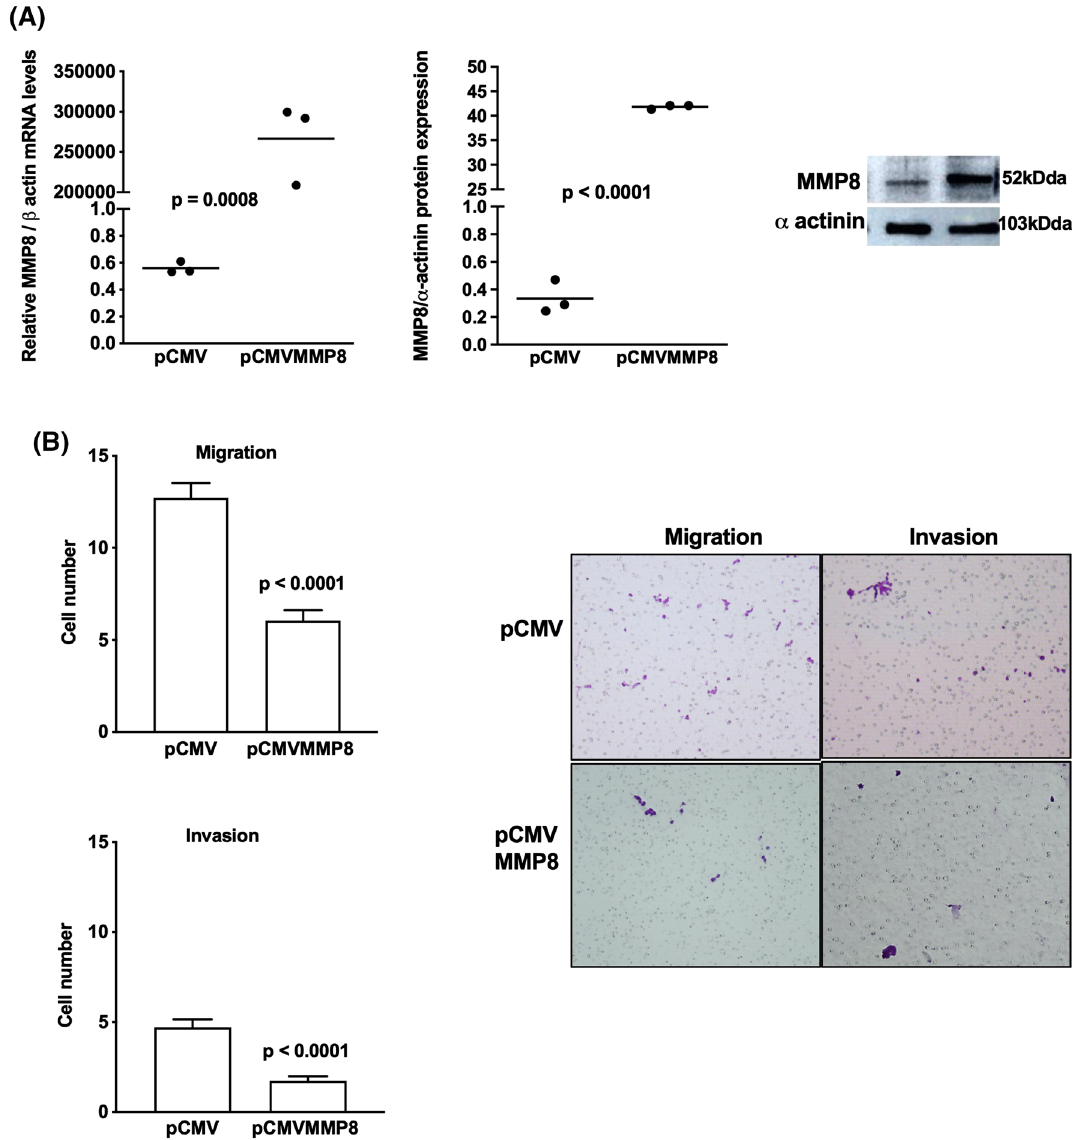
Fig. 8 Overexpression of metalloproteinase MMP-8 in adrenocortical carcinoma cells. A MMP-8 expression in H295R cells transfected with pCMVMMP-8 and empty vector; representative immunoblot of MMP-8 expression; B migration and invasion assays in H295R transfected with pCMVMMP-8 and representative stained membranes. The experiments were performed in triplicate and repeated three times. Magnifi- cation of membranes (100×). The results were expressed as the mean ± SD. Statistical significance was assessed by unpaired t